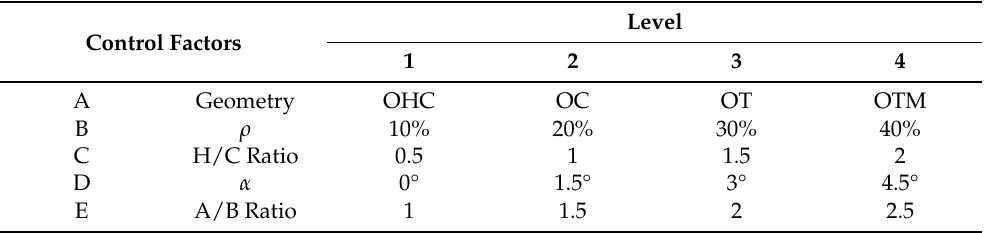
Table 1. Table 1. Lattice Structure Simulation Parameters.